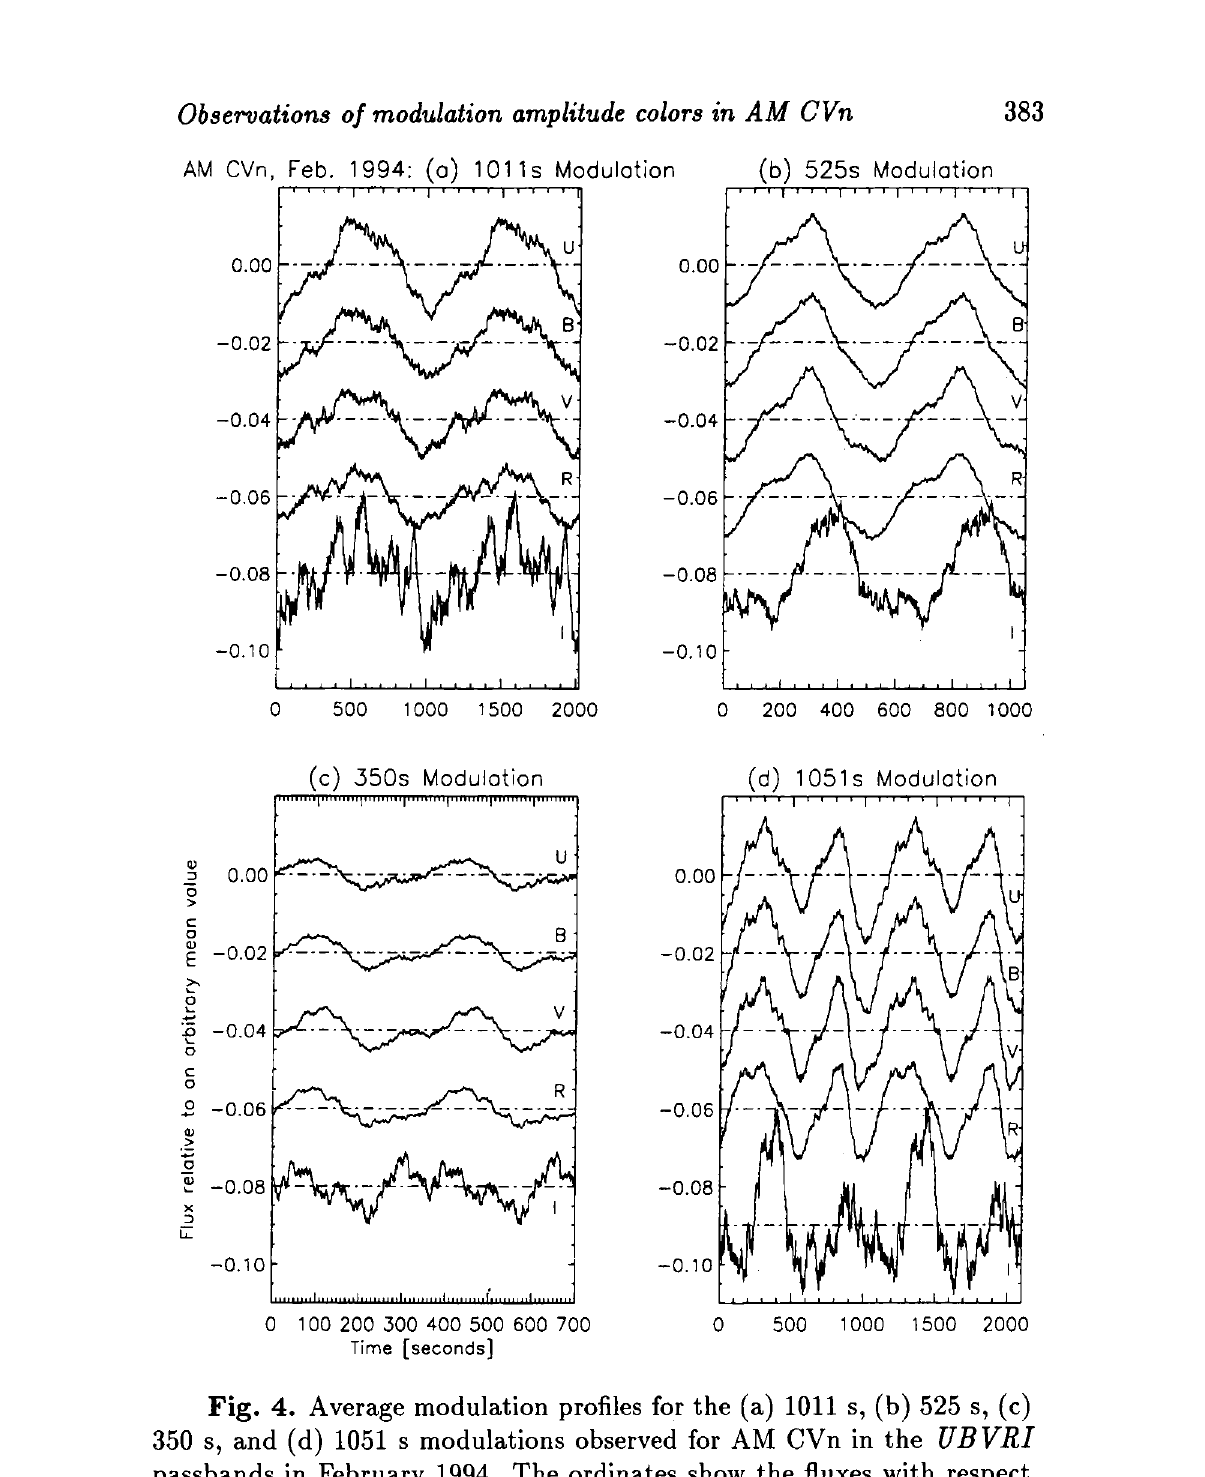
Fig. 4. Average modulation profiles for the (a) 1011 s, (b) 525 s, (c) 350 s, and (d) 1051 s modulations observed for AM CVn in the UBVRI passbands in February 1994. The ordinates show the fluxes with respect to arbitrary mean values. Each pulse is plotted over two